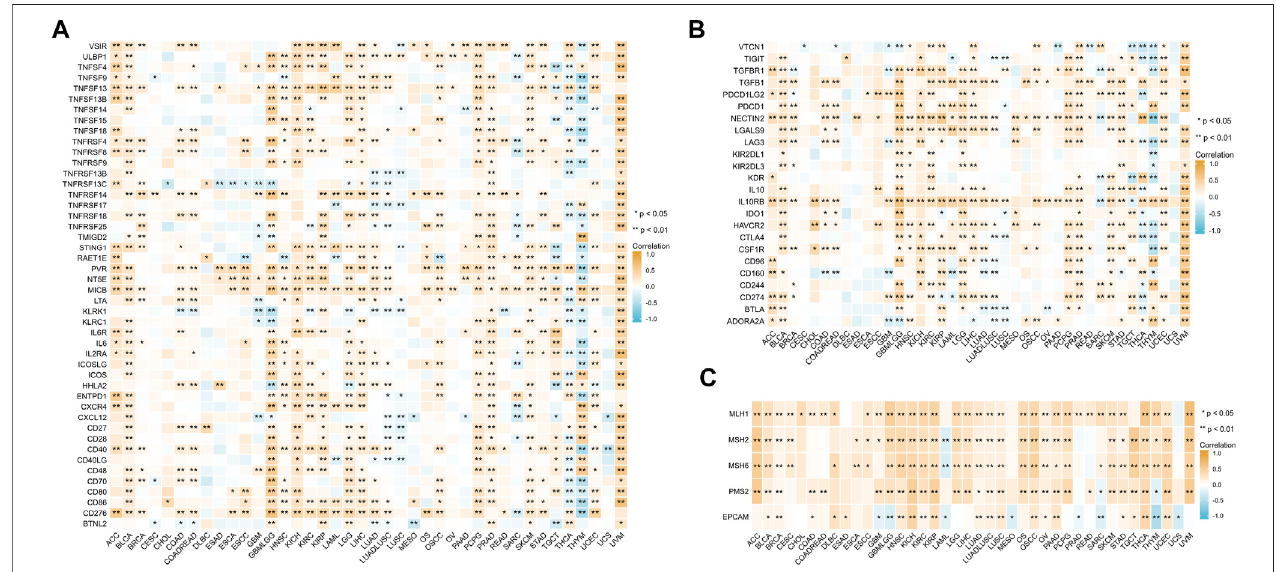
FIGURE 7 | Correlation between BCL7B gene expression and immune-activating genes (A) , immune-suppressing genes (B) , and DNA repair genes (C) . p p < 0.05 and pp p < 0.01.